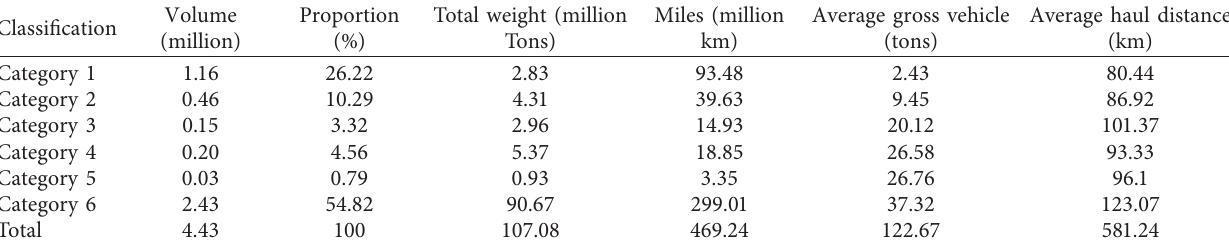
Table 6: Analysis on the proportion of goods vehicle traffic volume of each type (axle) of the second-class highway.